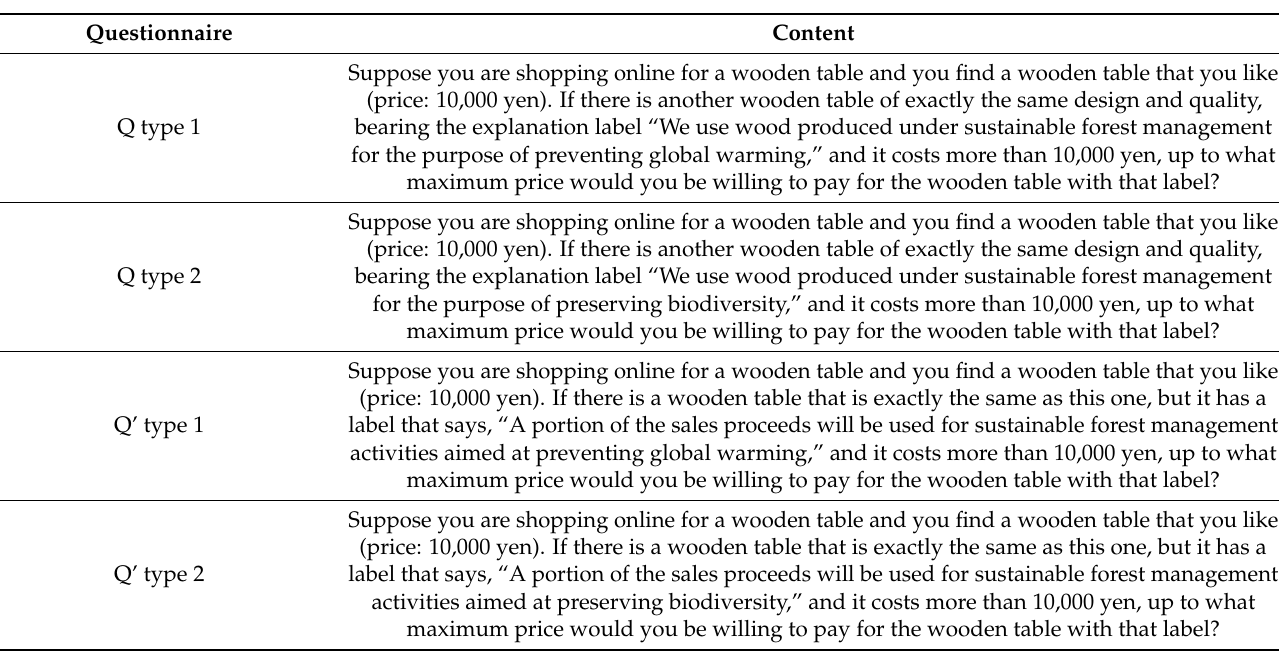
Table 1. Questionnaire of the